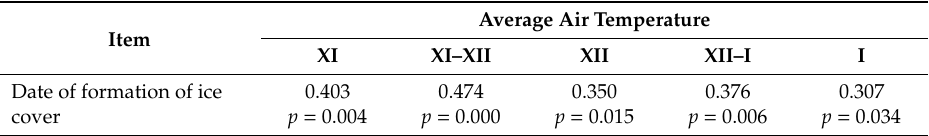
Table 3. Pearson’s correlation coe ffi cients between meteorological data and dates of ice cover formation for the Kozłowa G ó ra water